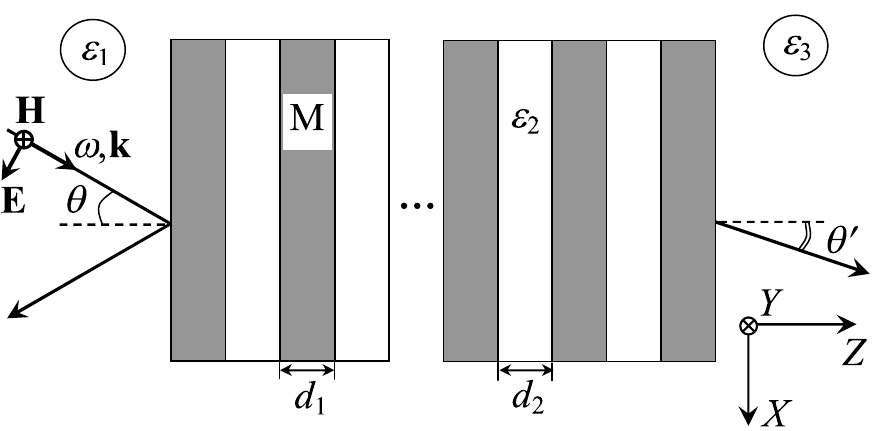
Figure 1. A scheme of E-wave propagation through 1D photonic crystal made of both weak conductor (M) and transparent dielectric ( ε 2 )